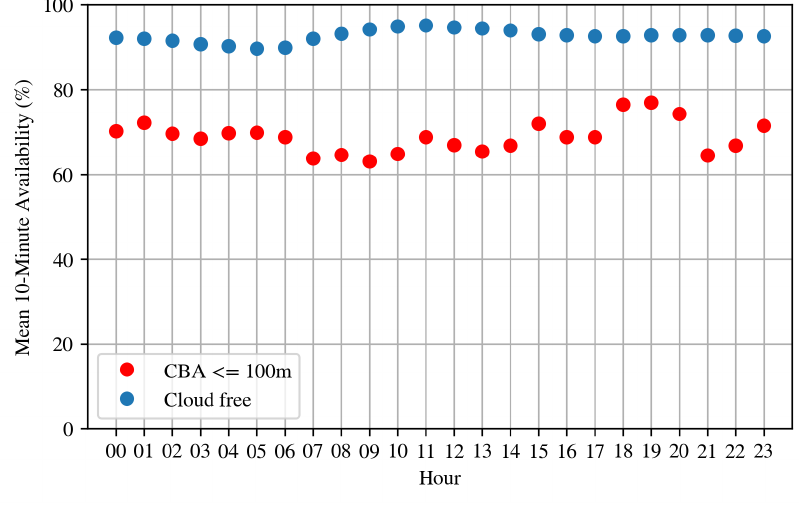
Figure 5. Diurnal mean availability for the measurement height bin of